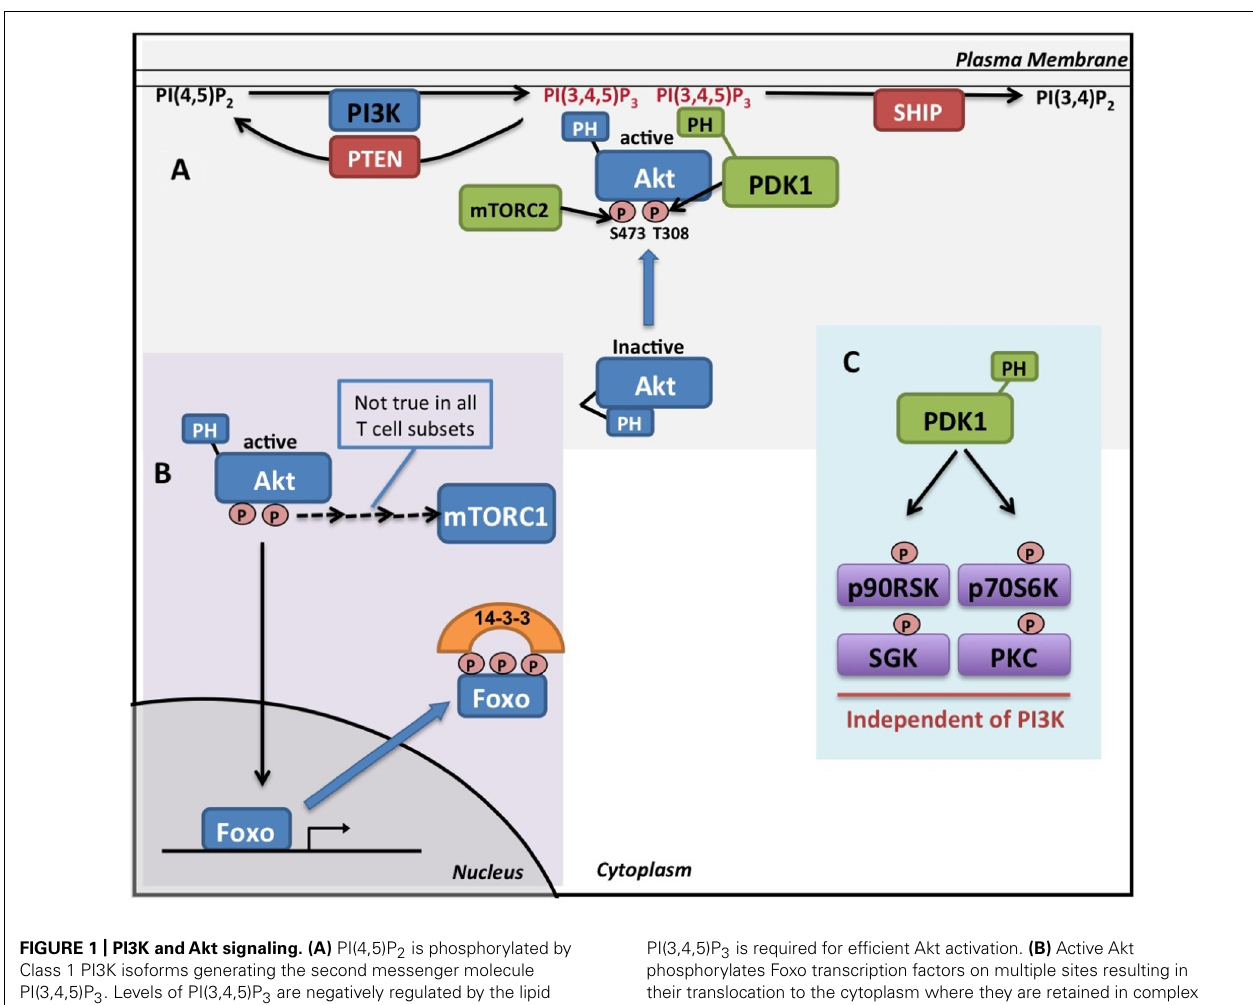
PI(3,4,5)P 3 is required for efficient Akt activation. (B) Active Akt phosphorylates Foxo transcription factors on multiple sites resulting in their translocation to the cytoplasm where they are retained in complex with 14-3-3 proteins. mTORC1 can be activated downstream of Akt, though this does not occur in allT cell types. (C) PDK1 also phosphorylates and activates a number of other members of the AGC kinase family in a PI3K independent